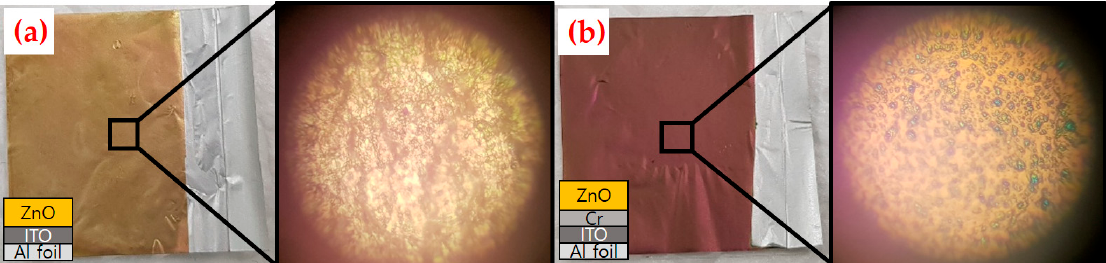
Figure 5. Comparison of optical micrographs of ( a ) ZnO / ITO / Al-foil and ( b ) ZnO / Cr / ITO / Al-foil structures after 20 bending cycles (sample bending was performed prior to the formation of the Ag top electrode). Each sample shows significantly different morphologies in the magnified micrographs (×400). More crack propagation seems to occur in the stacked film structure without a Cr layer.